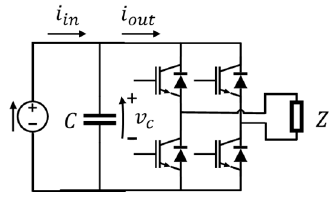
Figure 4. Equivalent circuit of a CHB